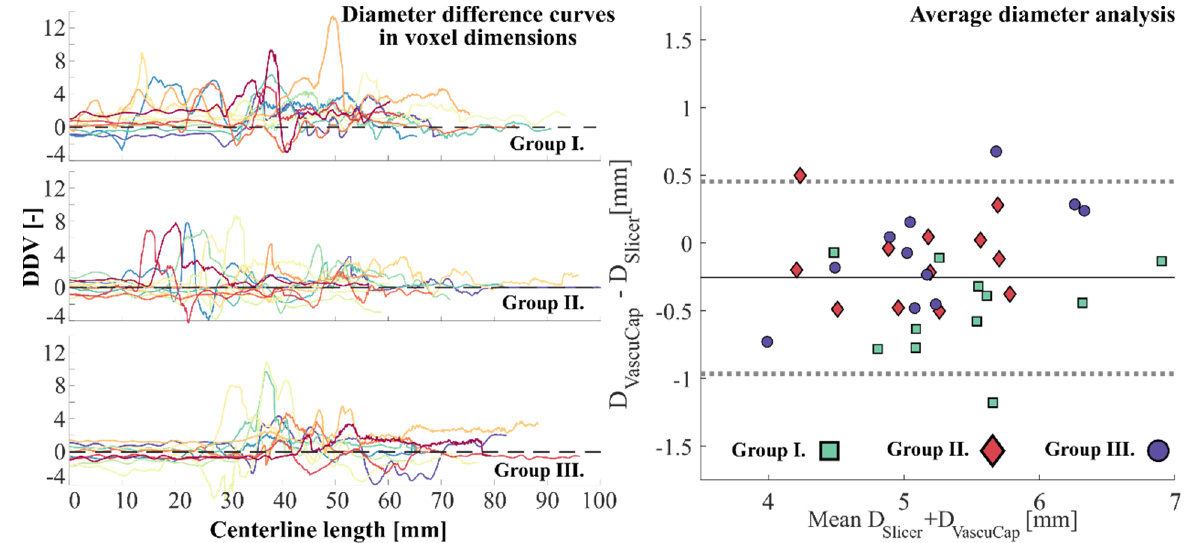
Figure 4. Left: Diameter difference curves normalized by the voxel dimension (DDV curves). Each subplot represents the collection of all cases within the respective group. Different colors were used only to distinguish between the cases. The left and right parts correspond to the beginning of the reconstructed CCA and ICA sections, respectively. Right: Bland–Altman plot on the analysis of the average diameters. ICA: internal carotid artery, CCA: common carotid artery. Group averages were computed with weighted averaging by the centerline length. Table 2. Top: Average diameter difference in voxel dimensions (ADDV) for each case. Bottom: Mean and Std. values for each group. The cases highlighted with orange shading were excluded from the calcification analysis due to lack of any